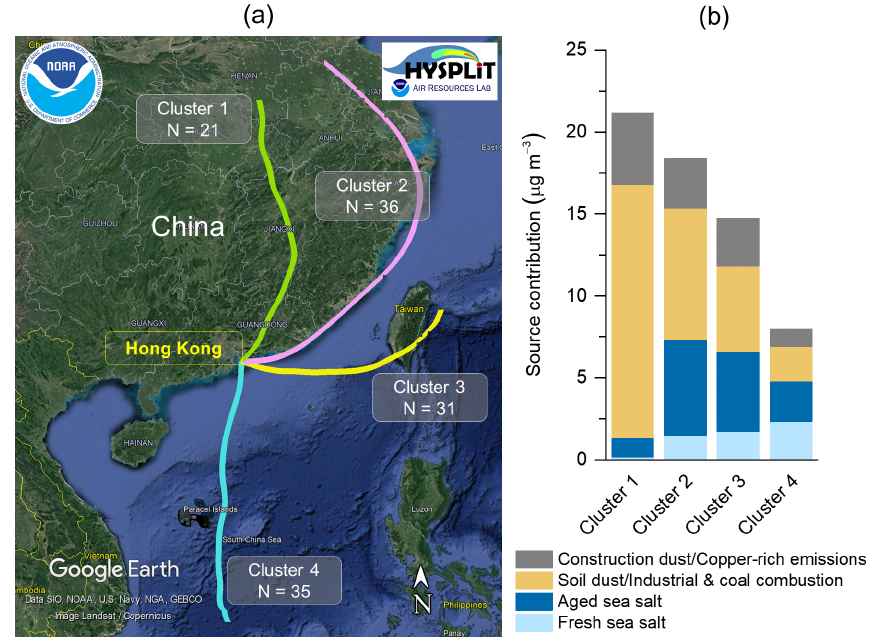
Figure 3. Source contributions to PM coarse grouped by air masses associated with different back-trajectory clusters. Past 48h backward trajectories of air masses reaching Hong Kong (height = 300ma.g.l.) during the end of each sampling event at midnight are considered. Panel (a) shows the mean trajectories of the four clustered trajectories (map data: Google Earth, Data SIO, NOAA, U.S. Navy, NGA, GEBCO, Image Landsat/Copernicus), while (b) shows the source contributions for the corresponding clusters.